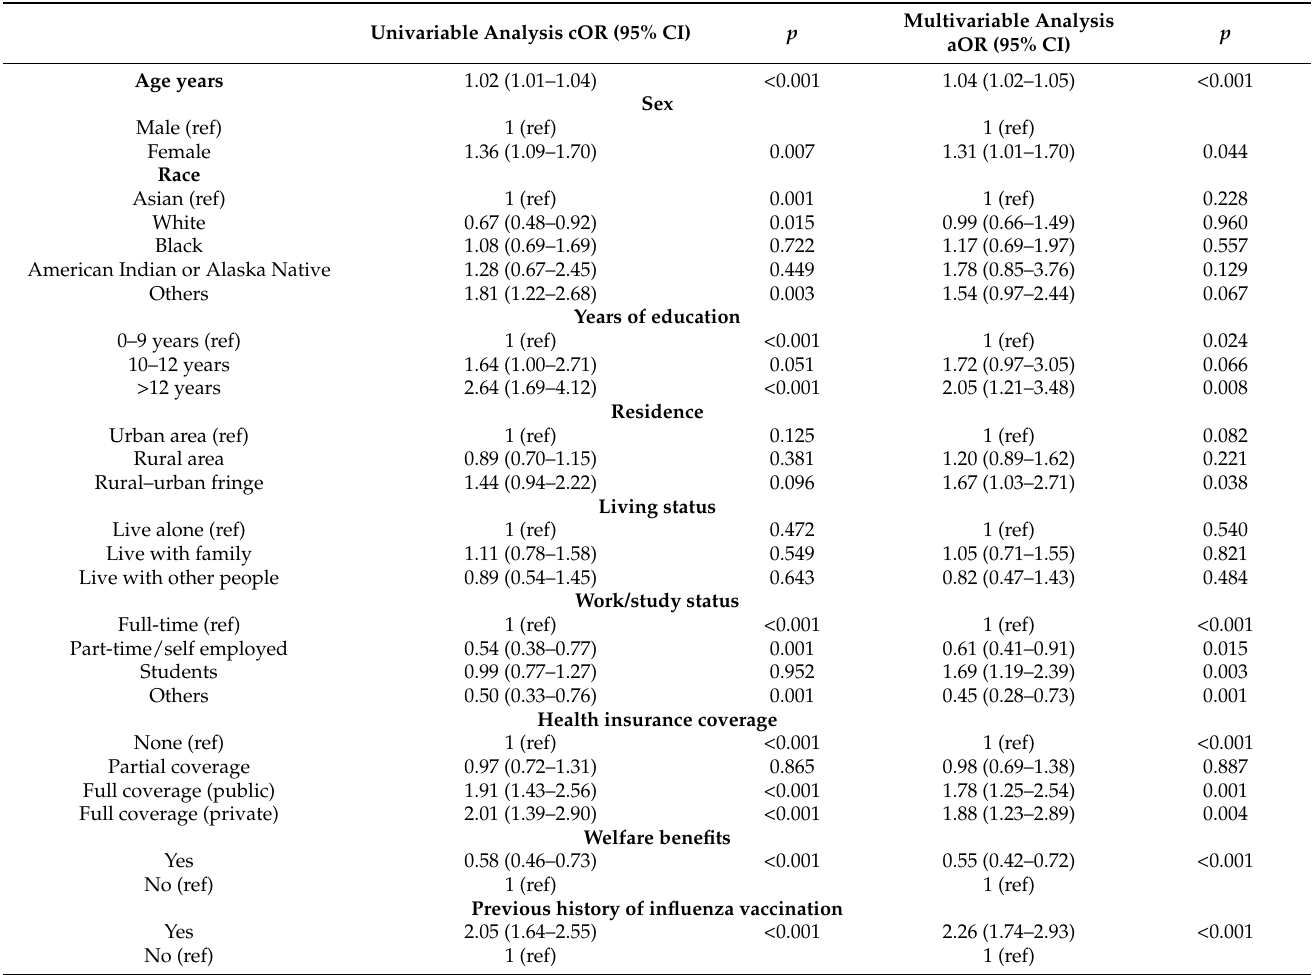
Table 2. Socio-demographic factors associated with COVID-19 vaccination